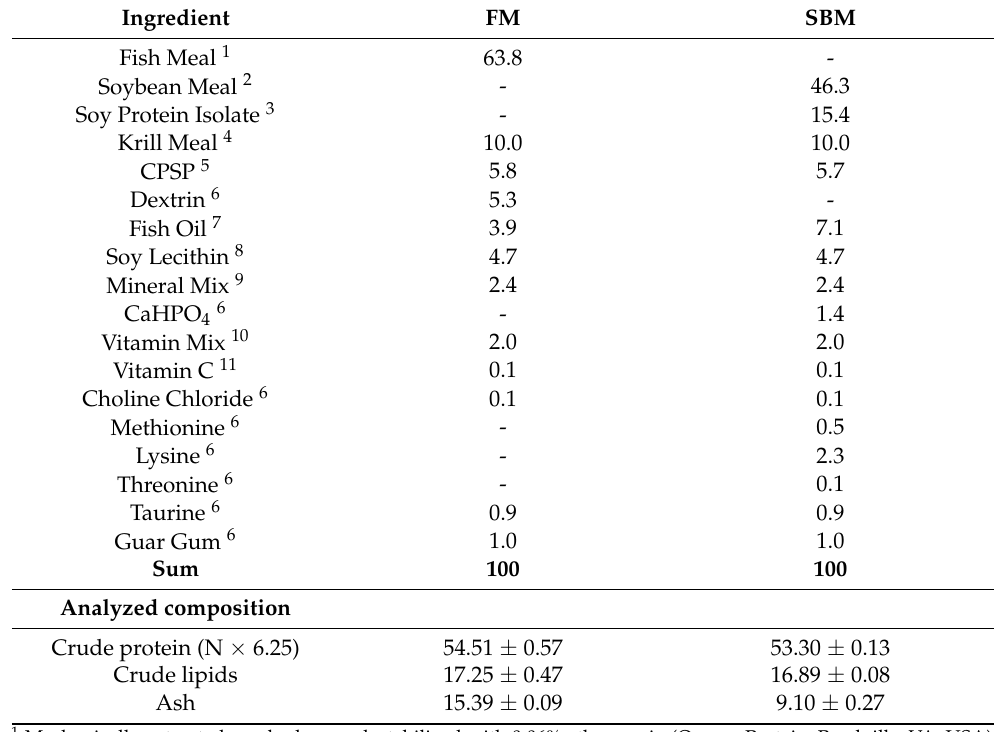
Table 1. Feed formulation of experimental diets (g/100 g) and their proximate composition (g/100 g). Ingredient FM